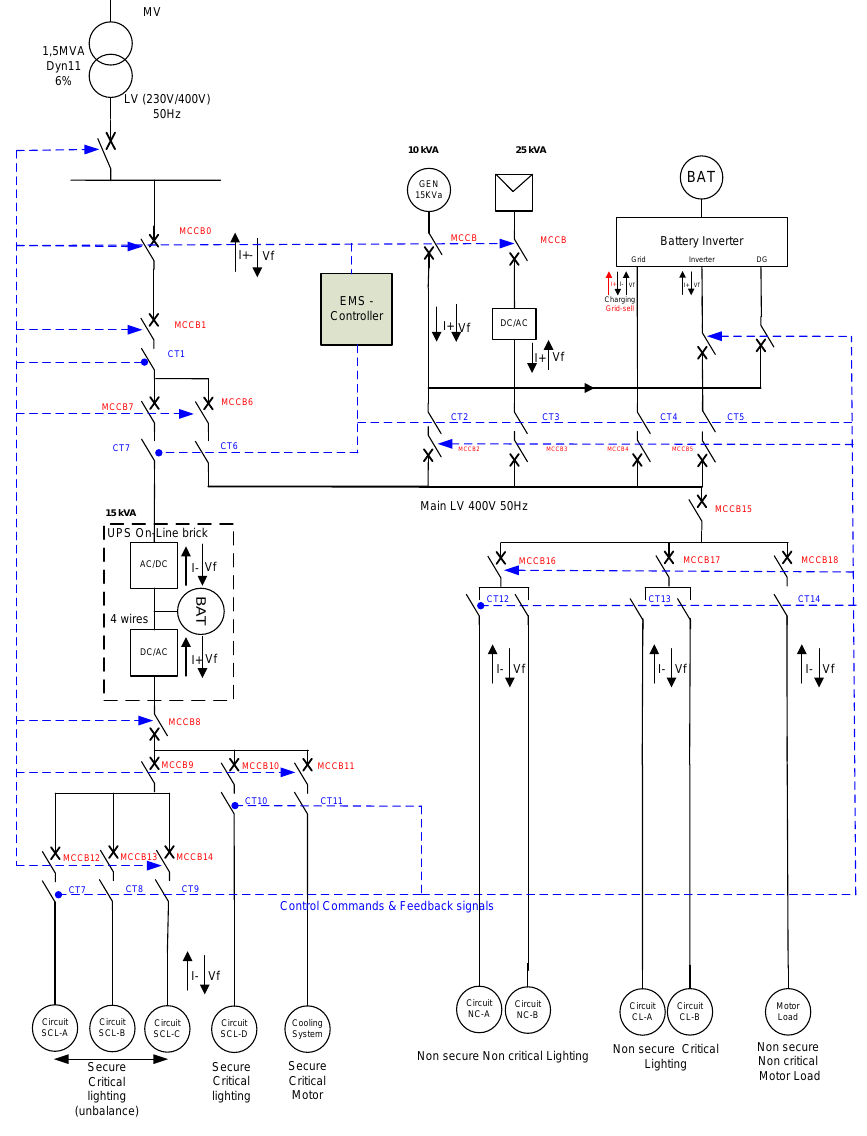
Figure 1. Microgrid schematic diagram.